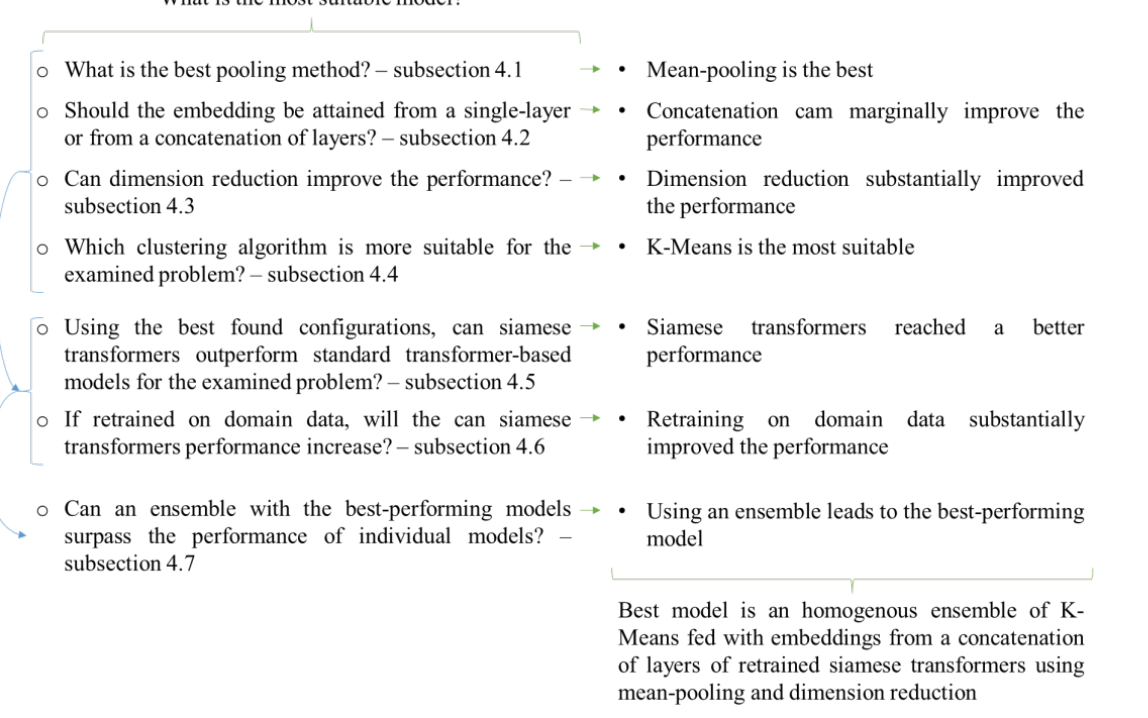
Figure 2. Sequence of followed-up queries and the conclusions reached after each experiment, indicating in which subsection the evaluation was performed.